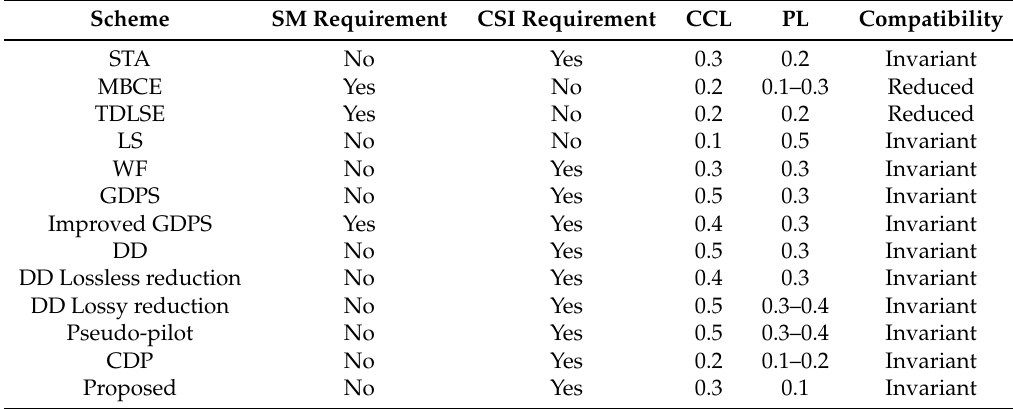
Table 3. Comparison of the proposed scheme with existing schemes for the Vehicle-to-Vehicle (V2V) channel Estimation.